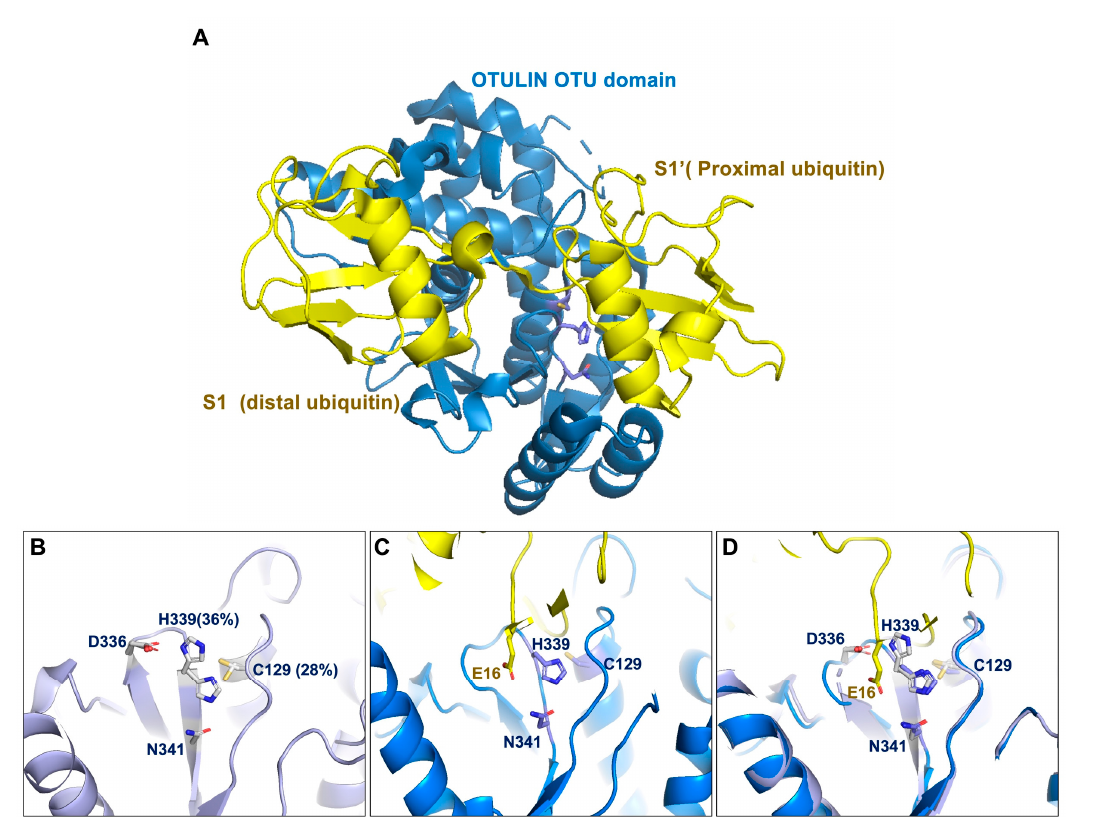
Figure 5. The structure of OTULIN. ( A ) Structure of OTULIN OTU domain in complex with Met1-di-ubiquitin. OTULIN (blue), ubiquitin (yellow). ( B ) Rearrangement of the active site residues in the absence (white blue) of bound Met1-di-ubiquitin. ( C ) Rearrangement of active site residues in the presence (blue) of bound Met1-di-ubiquitin. ( D ) Superposition of ( B , C ). (PDB: 3ZNZ and 3ZNV).